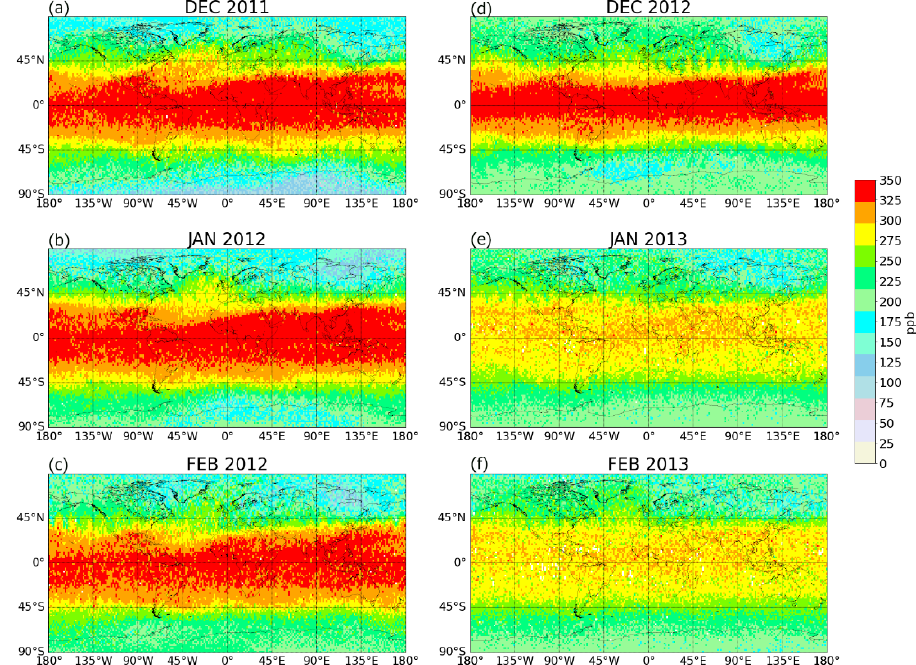
Figure 4. Monthly average N 2 O concentration from December 2011 to February 2012 ( a – c ) and from December 2012 to February 2013 ( d – f ) at 68.13 hPa.